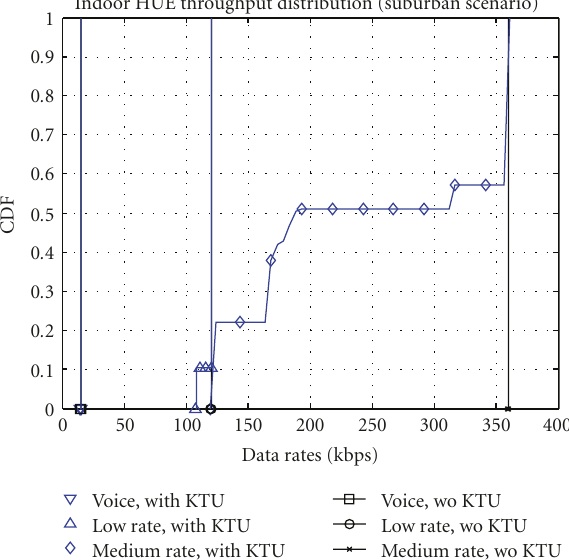
Figure 4: Distribution of outdoor HUE throughput in the presence of Kitchen Table MUEs.